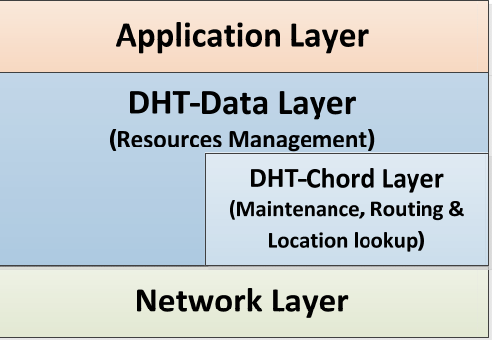
Figure 6. Proposed stack protocol of an operational peer for a generic DHT peer communication architecture.